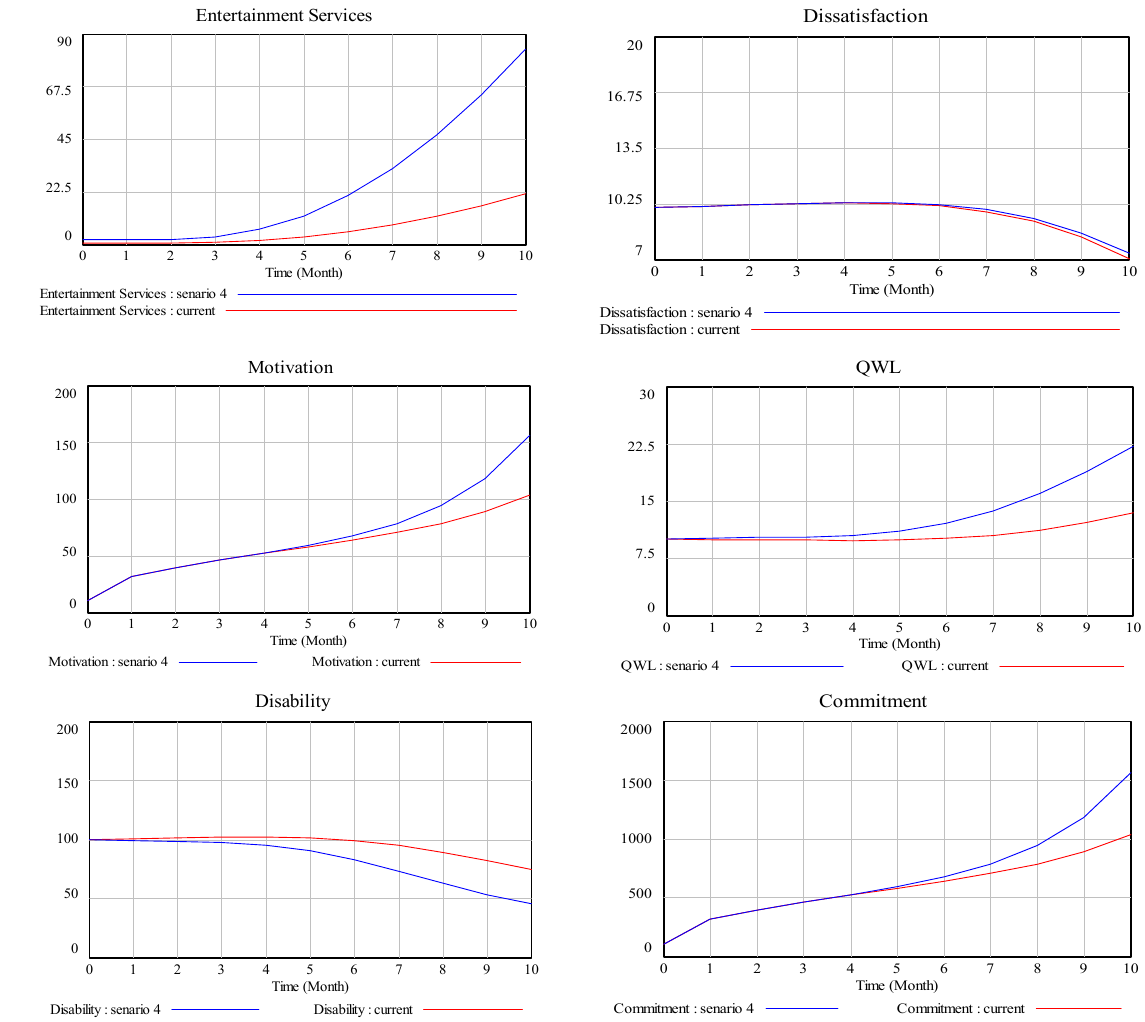
Fig. 8: The impact of improving entertainment services on the variables of the system dynamics model